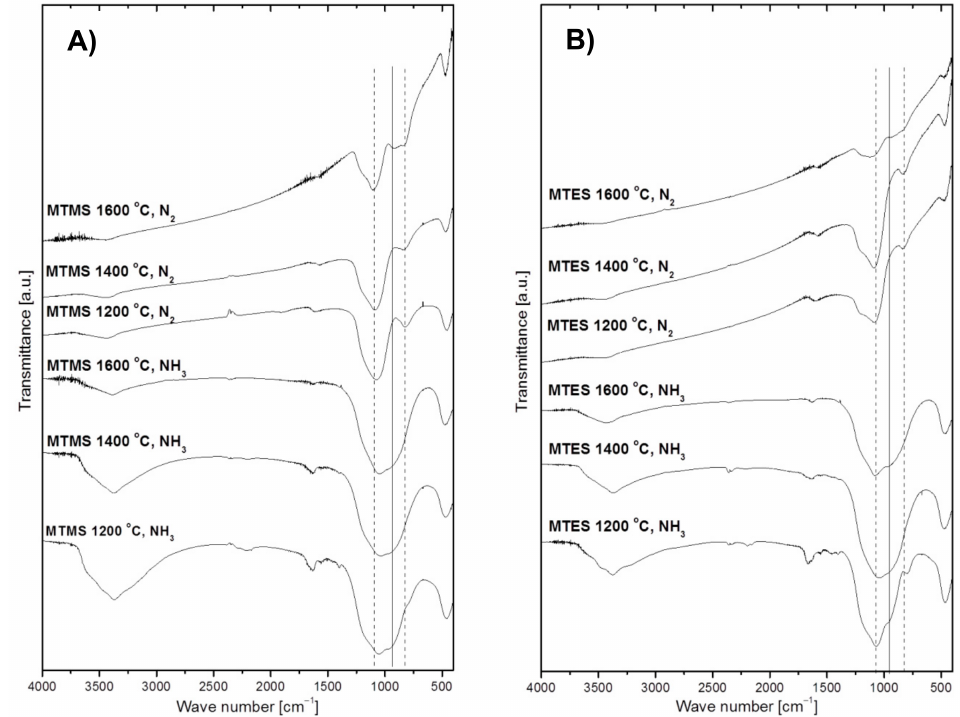
Figure 4. FT-IR spectra of powders produced by spray pyrolysis at different conditions. ( A )—from MTMS, ( B )—from MTES. The vertical dashed lines crossing frequent peak positions for Si–O bonds (left line at 1070 cm − 1 ) and Si–C bonds (right line at 820 cm − 1 ) as well as the solid line for Si–N bonds (middle line at 950 cm − 1 ) are guides for eye,